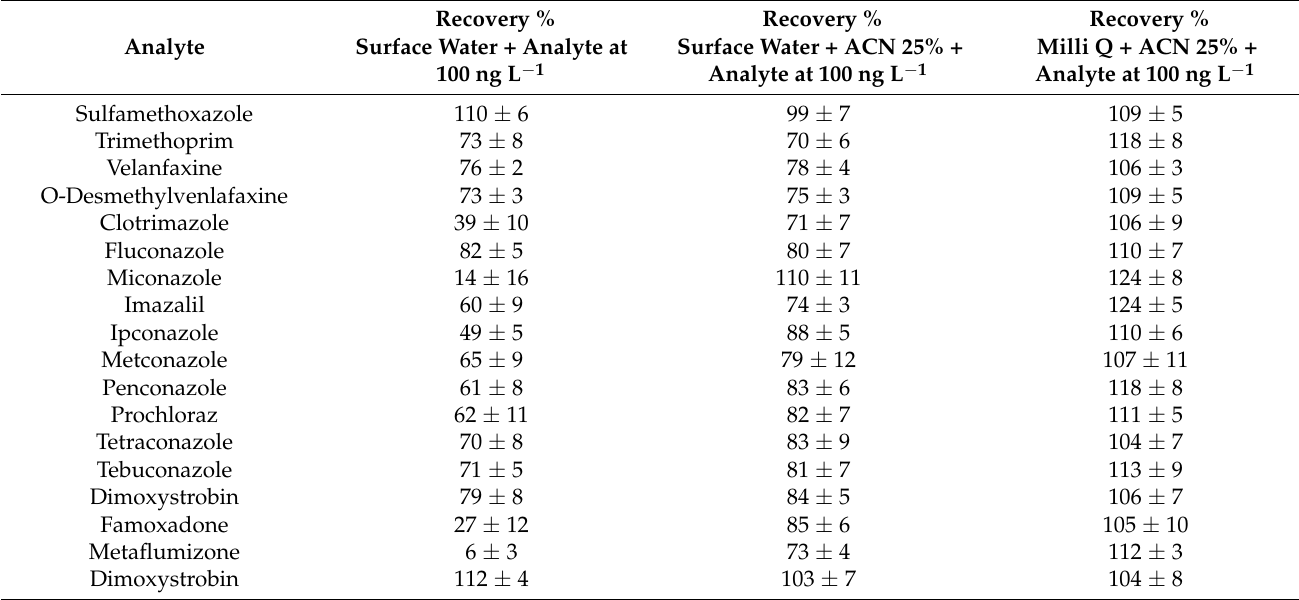
Table 5. Percentage recovery of analyte at 100 ng L − 1 in Surface water + ACN 25%, Milli Q + ACN 25%, Surface Water + ACN 25% and Milli Q + ACN